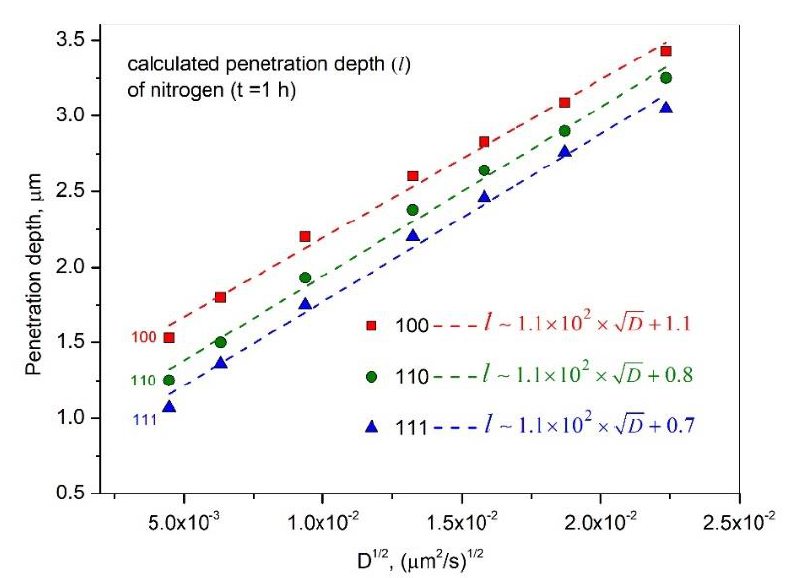
Figure 7. The dependence of penetration depth on diffusion coefficient for different crystalline orientations of AISI 316L single crystals (nitriding duration 1.00 h).